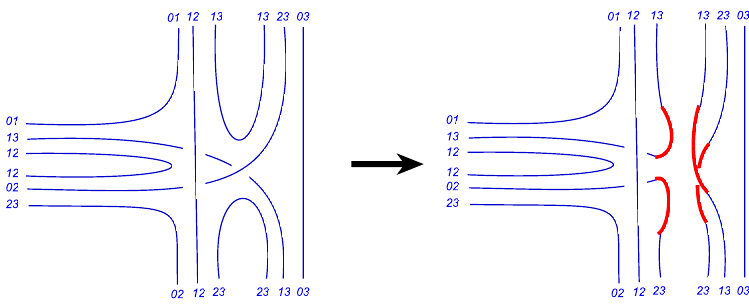
Figure 17 . The move to separate out a single line from a 6-valent vertex to make a 4-valent vertex. In the left panel, the 6-valent vertex carries indices f 1 ; 1 ; 2 ; 2 ; 3 ; 3 g and we can strip o(cid:11) the line 3 by breaking 2 virtual loops and reconnecting the open ends shown by the bold strands in red.